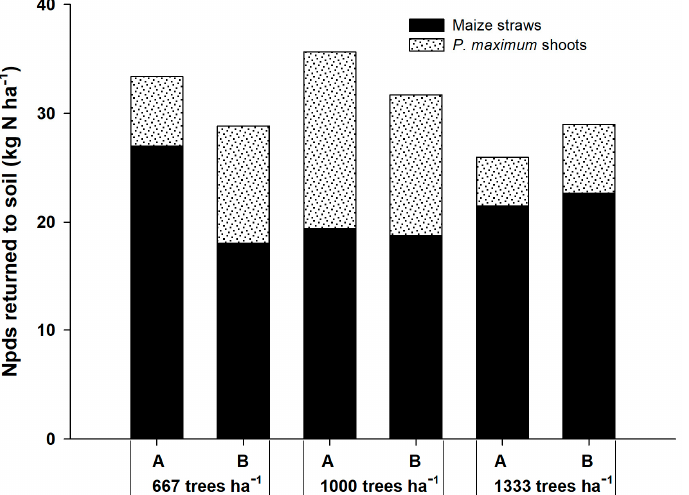
Figure 2. Nitrogen in plant derived from the soil (Npds) that returned to the soils by corn straws and shoots of P. maximum in three agrisilvicultural systems with 667, 1000 and 1333 plants of G. sepium ha − 1 . A and B represent the corn rows adjacent to the trees and in the center of the plots, respectively.